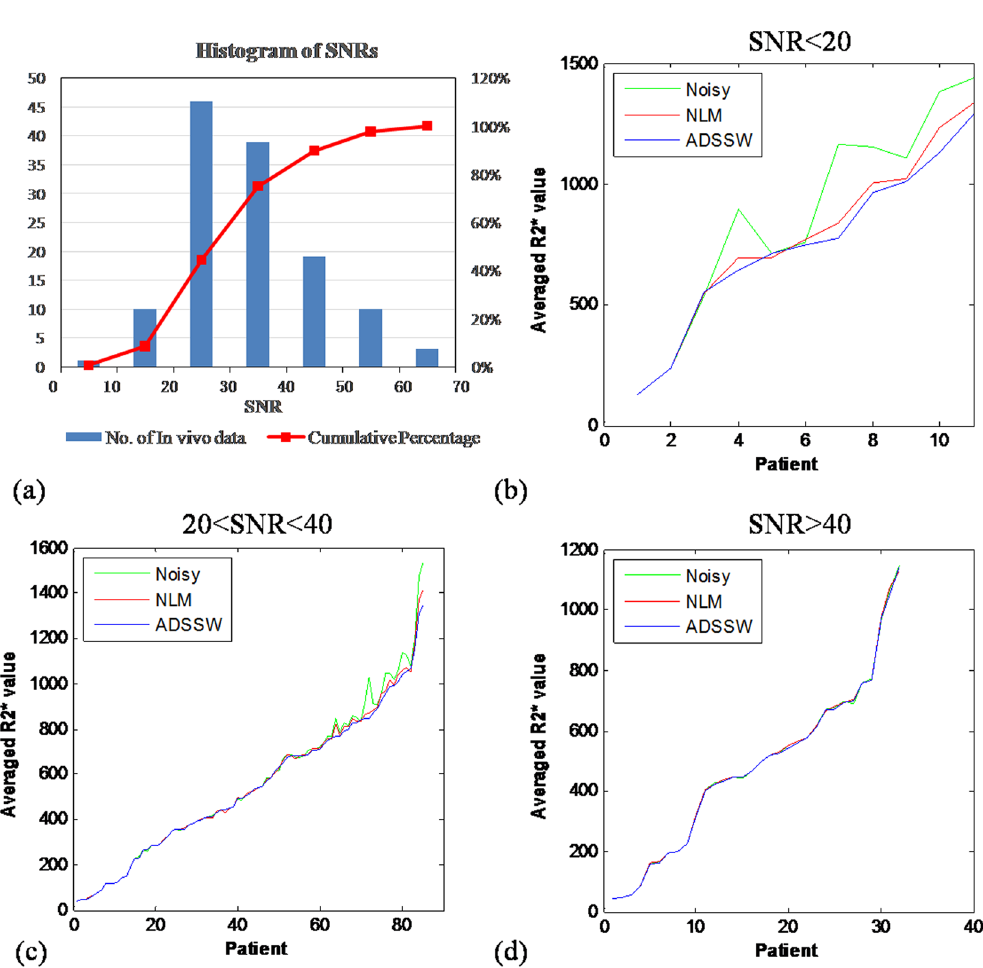
Figure 6. R2 * quantification analysis for all the in vivo data sets (n = 128). ( a ): the histogram of the SNRs with cumulative percentage, ( b – d ): plot of the representative R2 * values from the noisy, NLM- and ADSSW-filtered data in ascending order of R2 * values for SNR < 20, 20 < SNR < 40 and SNR > 40,